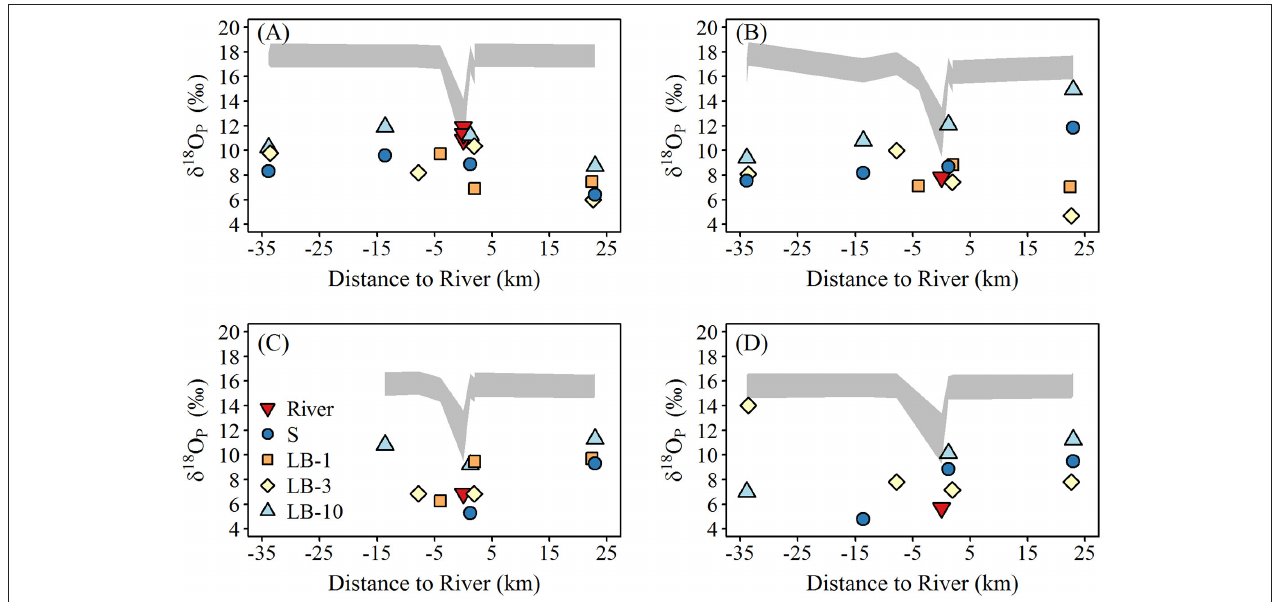
FIGURE 6 | Spatial variation of δ 18 O p ( ‰ ; symbols) and the calculated equilibrium window ( δ 18 O P_EQ ) at lake sites during (A) late May—early June, (B) mid-June, (C) mid-July, and (D) late August. The equilibrium window ( δ 18 O P_EQ ) was calculated using the minimum and maximum measured water δ 18 O w over the study period using the equation of Chang and Blake